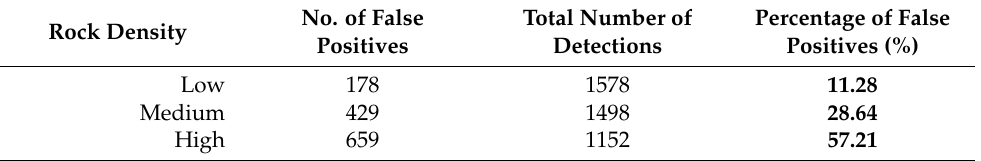
Table 6. Results of automated image analysis showing the total number of false positives in each density category as well as the total number of detections and a calculated percentage of false